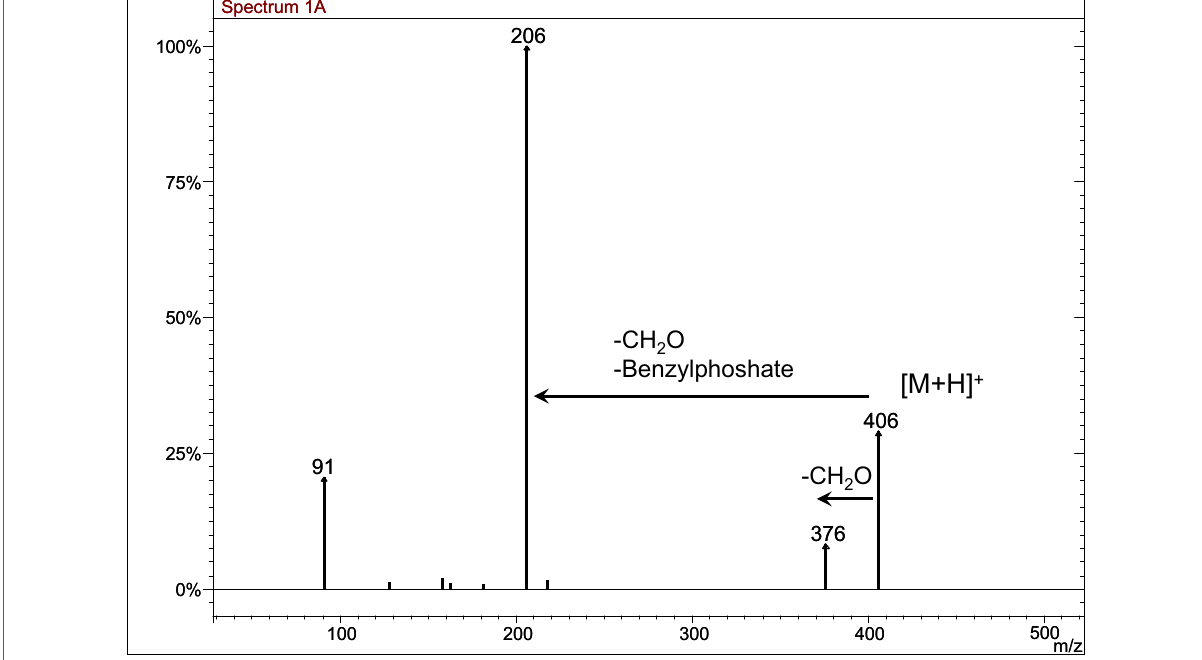
Fig. 8 MS/MS spectra of [M